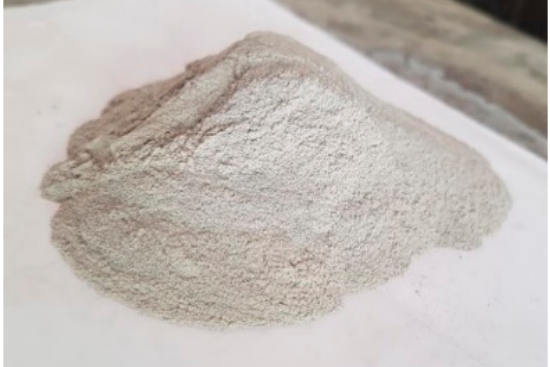
Figure 3. Fly ash—cementitious alternate.